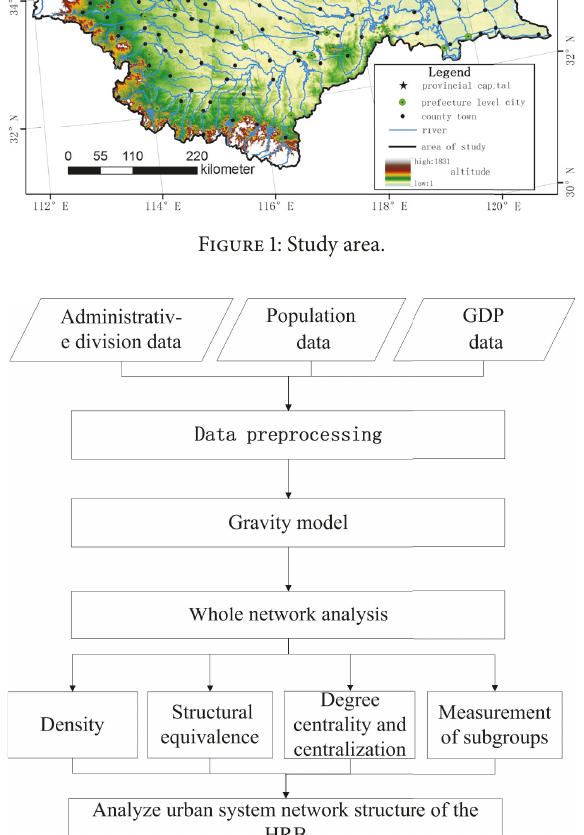
Figure 2: The process of whole network analysis.